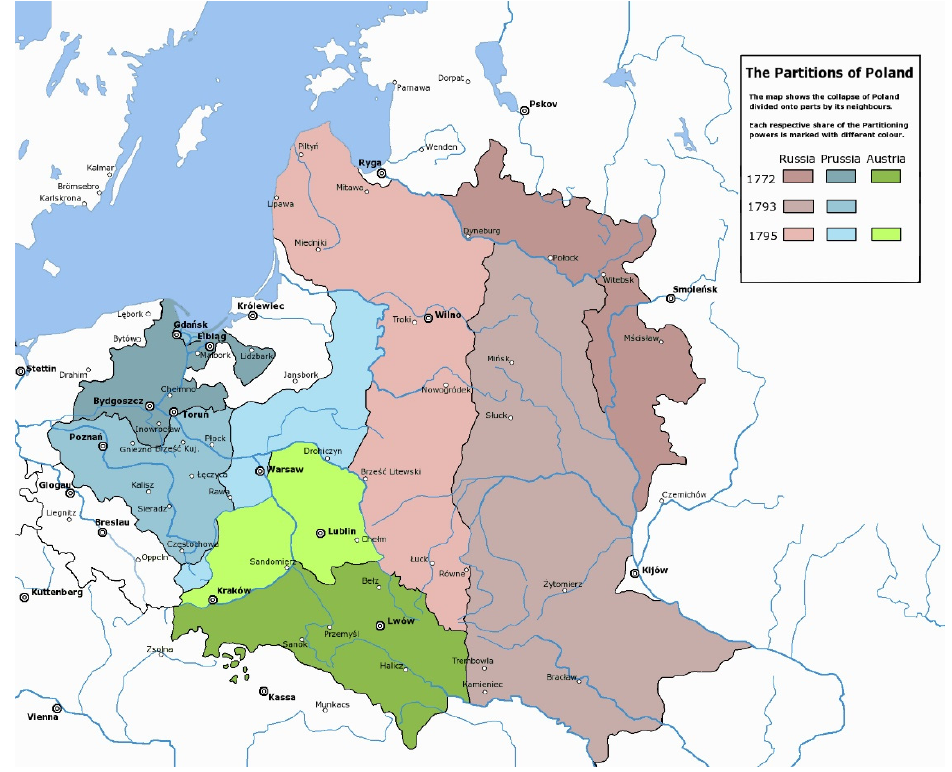
Figure 2. Partitions of Poland, (1772, 1793, 1795). The map shows the collapse of Poland divided into parts by its neighbors. As a result, Poland disappeared from the maps for 123 years and lost access to the sea and the opportunity to shape coastal buildings. Source: Halibutt, Wikipedia, the free encyclopedia. German resorts, such as Sopot (Zoppot), ´Swinouj´scie (Swinemünde) or Kołobrzeg